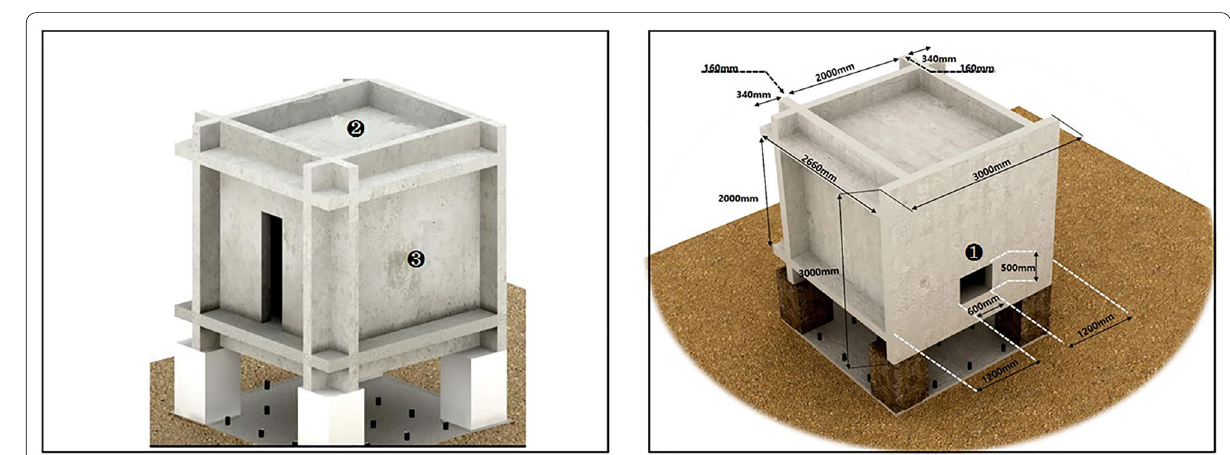
Fig. 5 Displacement sensor